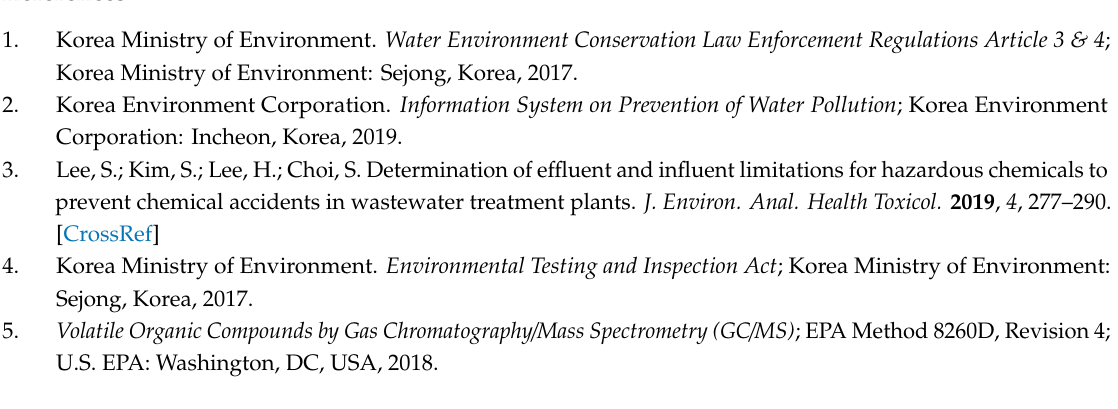
Figure S1: Data assignment under headspace extraction and injection conditions (left: single-compound injection, right: multi-compoundinjection), TableS1: Physico / chemicalpropertiesoftargetcompoundsforchemicalaccidents and leakages, Table S2: Reaction ion, mass, and theoretical and measured reaction ratios of target